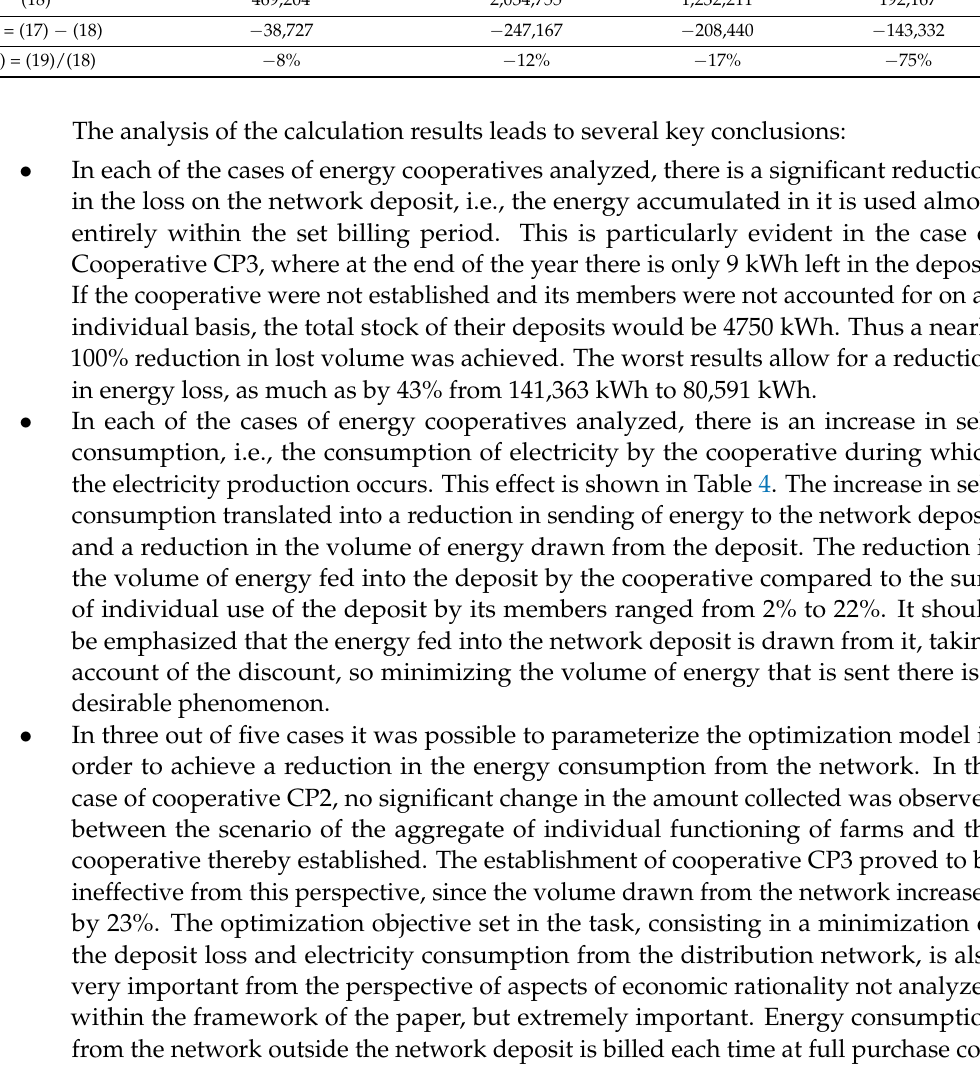
Consumption from the Network Sending to the Collection from the Loss on the (Outside the Network Deposit) Network Deposit Network Deposit Network [kWh/Year] [kWh/Year] [kWh/Year]